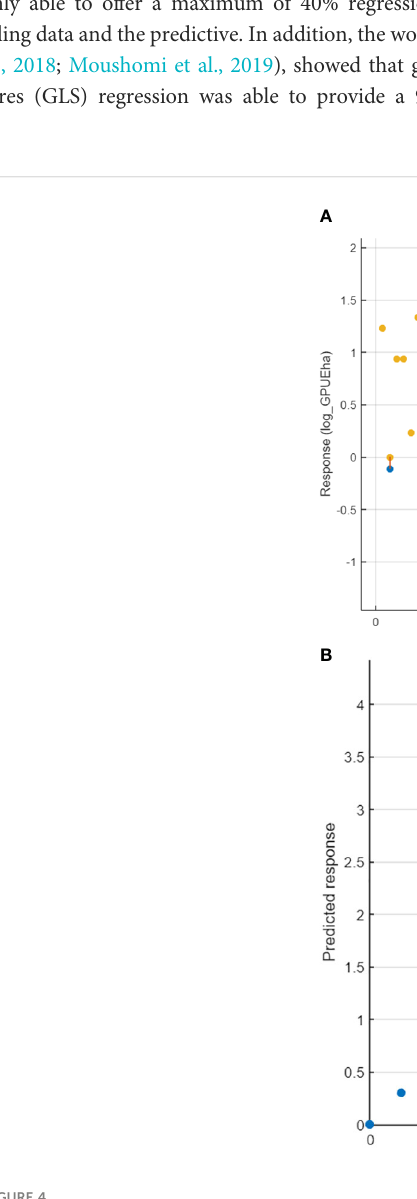
FIGURE 4 Comparison between output of Catch results and output of GPR model for eDNA copies. (R = 96%, Error MAE = 0,002). (A) co-Plot of the real data from trawl (blue) and the predicted basing on the eDNA model (yellow), the x-axis present predictive values of Log Depth (log Deep) of sampling and number of DNA copies (Log Copies); most of data were in predicted as it was observed. (B) The correlation between predicted data by the model (Predicted response) and the real data collected from trawl (True